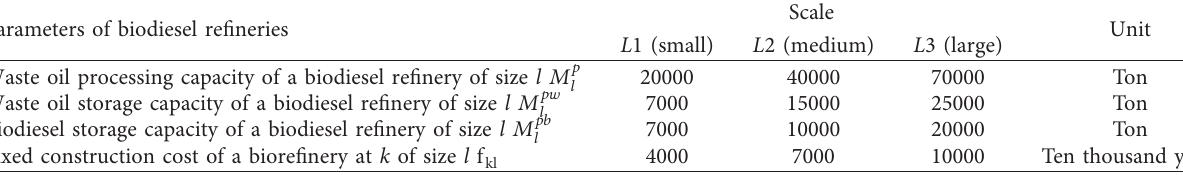
Table 5: Parameters of biodiesel refining plants.